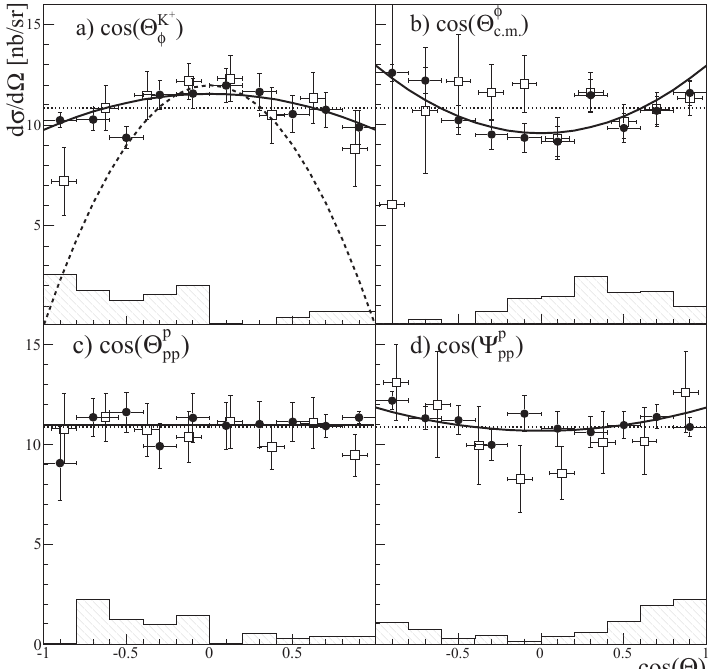
Fig. 3. Angular distributions measured for the pp → ppφ reaction (black circles) compared with the scaled DISTO data (open squares). The solid curves show fits to the ANKE results for (a) the φ decay angle, (b) the φ c.m. angle, (c) the proton Jackson angle, and (d) the proton helicity angle. An extended description can be found in the full article